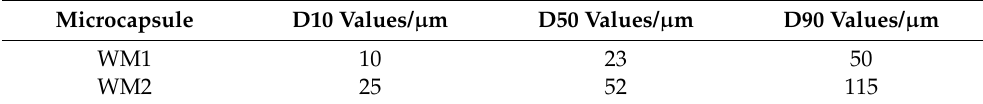
Figure 4. Particle size distribution of microcapsules. Table 6. Particle sizes of